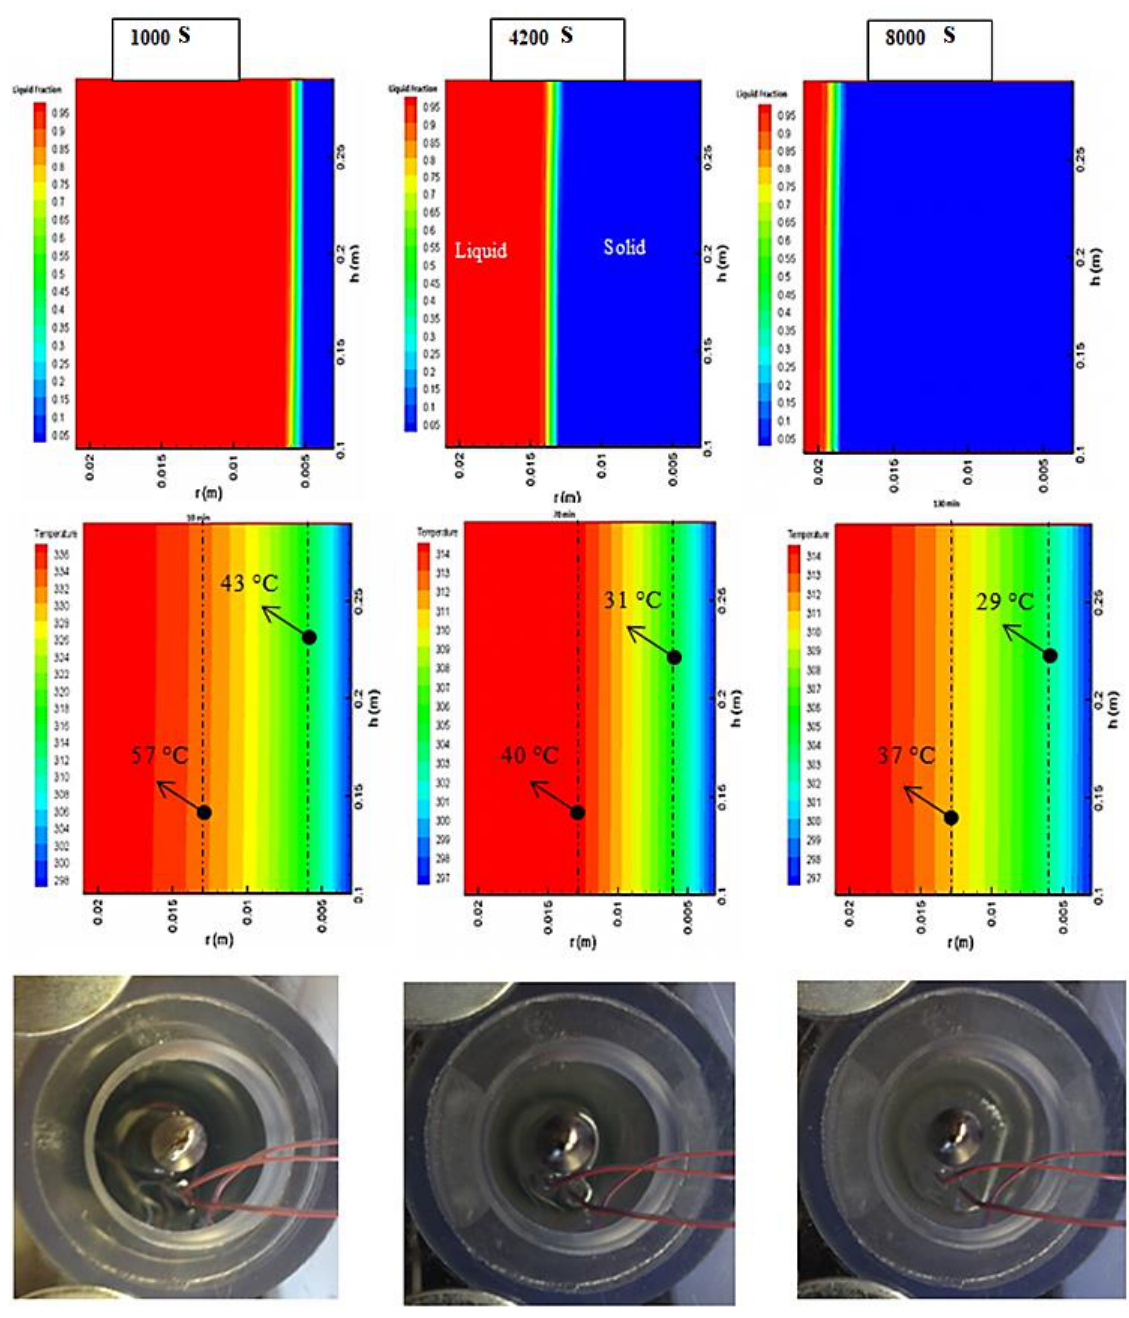
Figure 11. Experimental solidification photos ( bottom ), numerical temperature contour ( middle ), and numerical liquid fraction in PCM ( top ) during discharging process (T = 23 °C) .